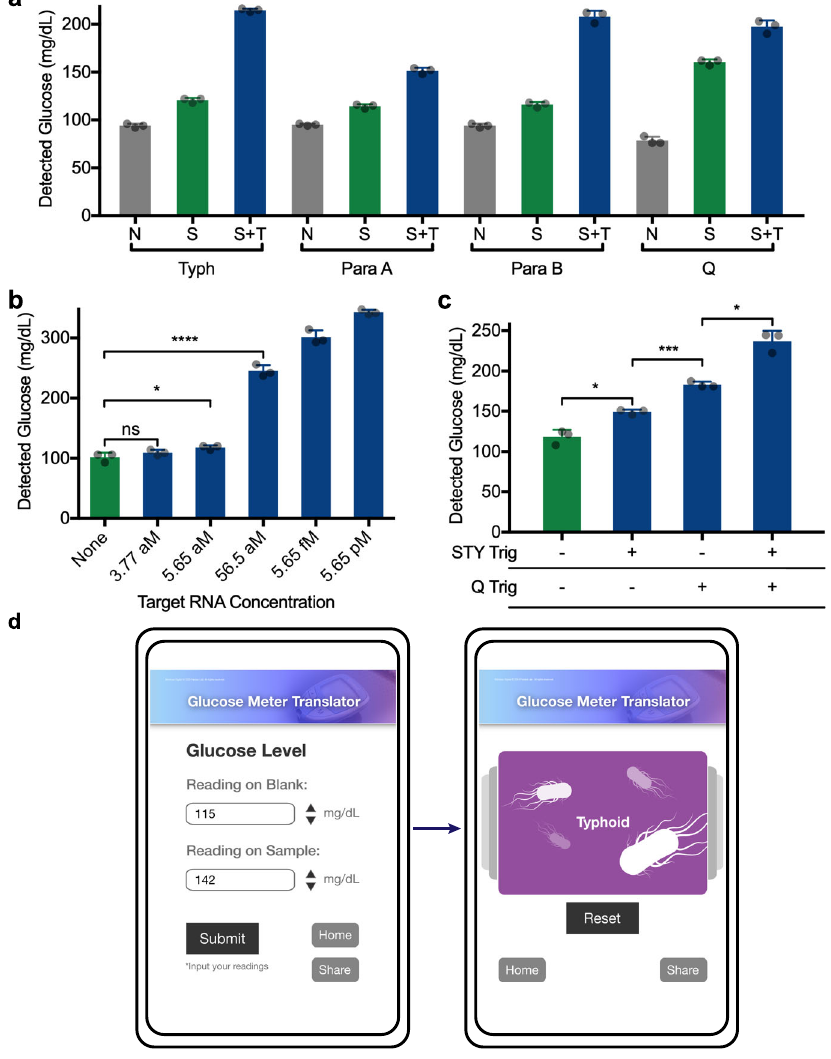
Fig. 3 Demonstration of typhoid- and paratyphoid-speci fi c toehold switches. a Glucose output from the detection of RNA sequences related to typhoid (Typh), paratyphoid A (Para A), paratyphoid B (Para B), and fl uoroquinolone resistance (Q). CFS background (N, no switch/trigger), switch alone (S, no trigger), and switch with target (S + T) are shown for each experiment. Typh, Para A, Para B switches at 312.5 pg/ µ L and targets at 50 nM. Q switch at 1.25 ng/ µ L and target at 100 nM. For each set 3 technical replicates are shown, representative of 3 independent experiments. b NASBA ampli fi cation of STY RNA at the given initial concentrations followed by glucose generation reaction. Typh switch at 1.25 ng/ µ L. * p = 0.0460; **** p < 0.0001. 3